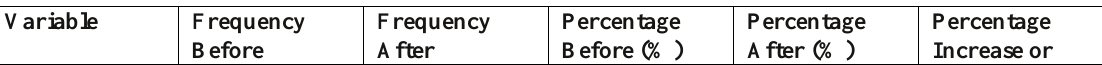
Table 6: Asset Before and After RUDEP